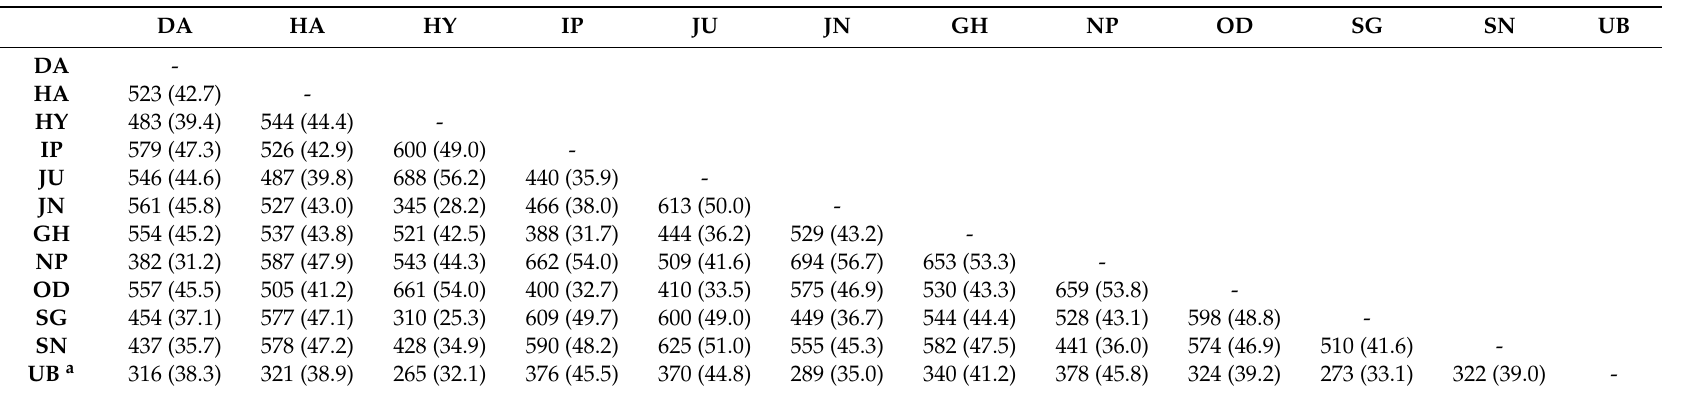
Table 5. The number and percentage of polymorphic KASP markers for genotype analysis of cross combinations between 12 Korean temperate japonica rice varieties. These varieties were used in common in the present and previous